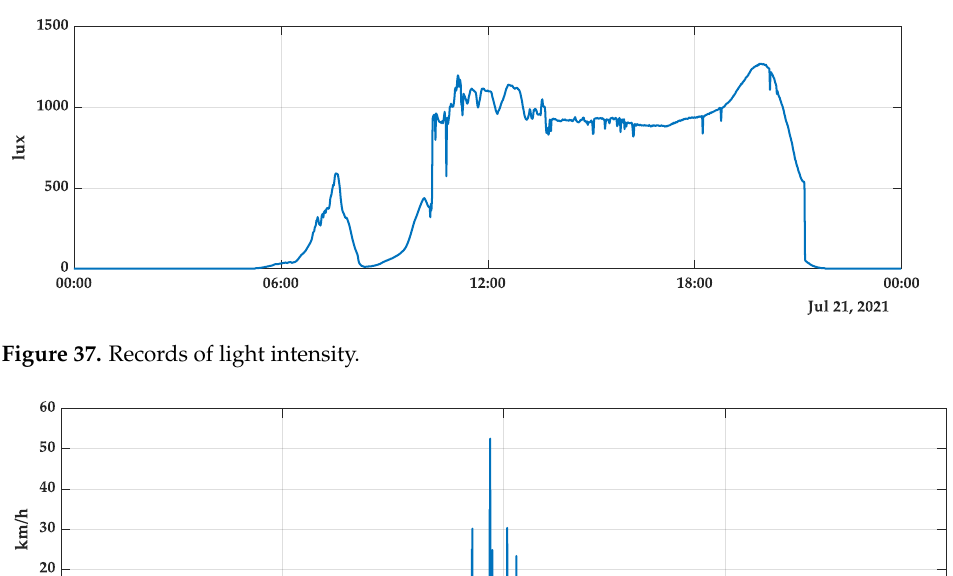
Figure 36. Records of relative air humidity.